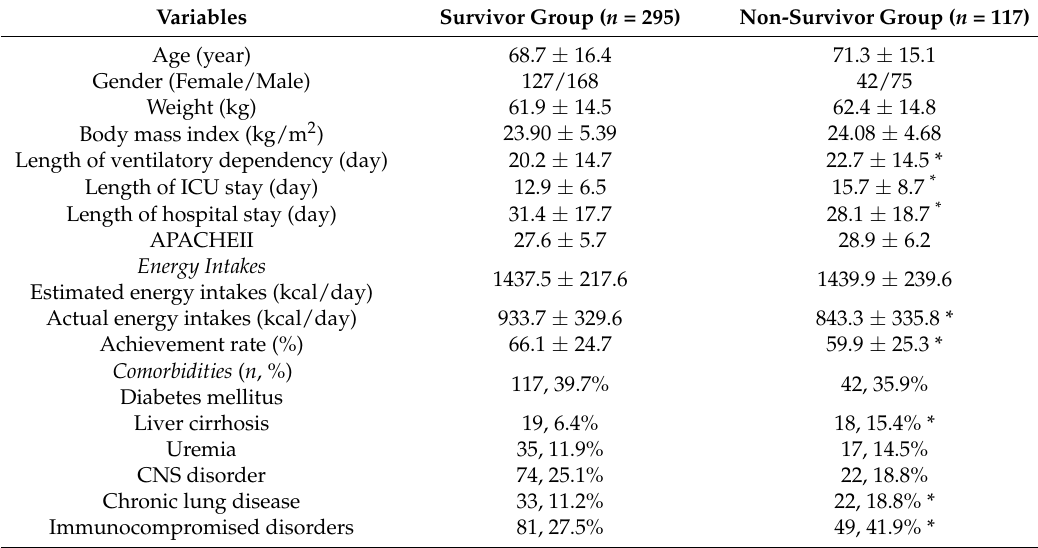
Table 2. Patients’ demographic characteristics, clinical outcomes, and energy intakes in survivor and non-survivor